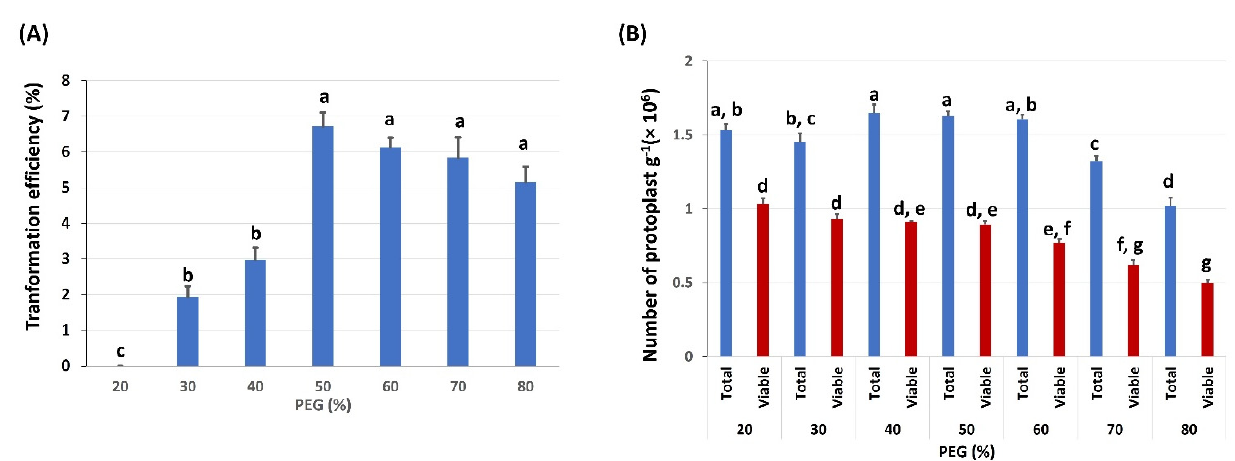
Figure 3. Effect of PEG concentration on protoplast transfection: ( A ) the transformation efficiency (TE) of protoplasts cultivated with various concentrations of PEG. TE was calculated after 24 h cultivation; ( B ) the effects of PEG concentration on the number of protoplasts. The number of total protoplasts and viable protoplasts counted after 24 h cultivation. Values represent means ± SE ( n = 7). The different letters indicate significant differences at p <